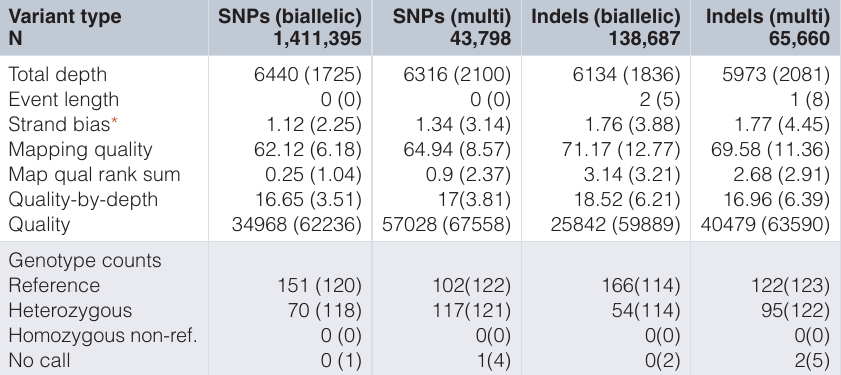
Table 1. Haplotype Caller variant quality metrics and genotype